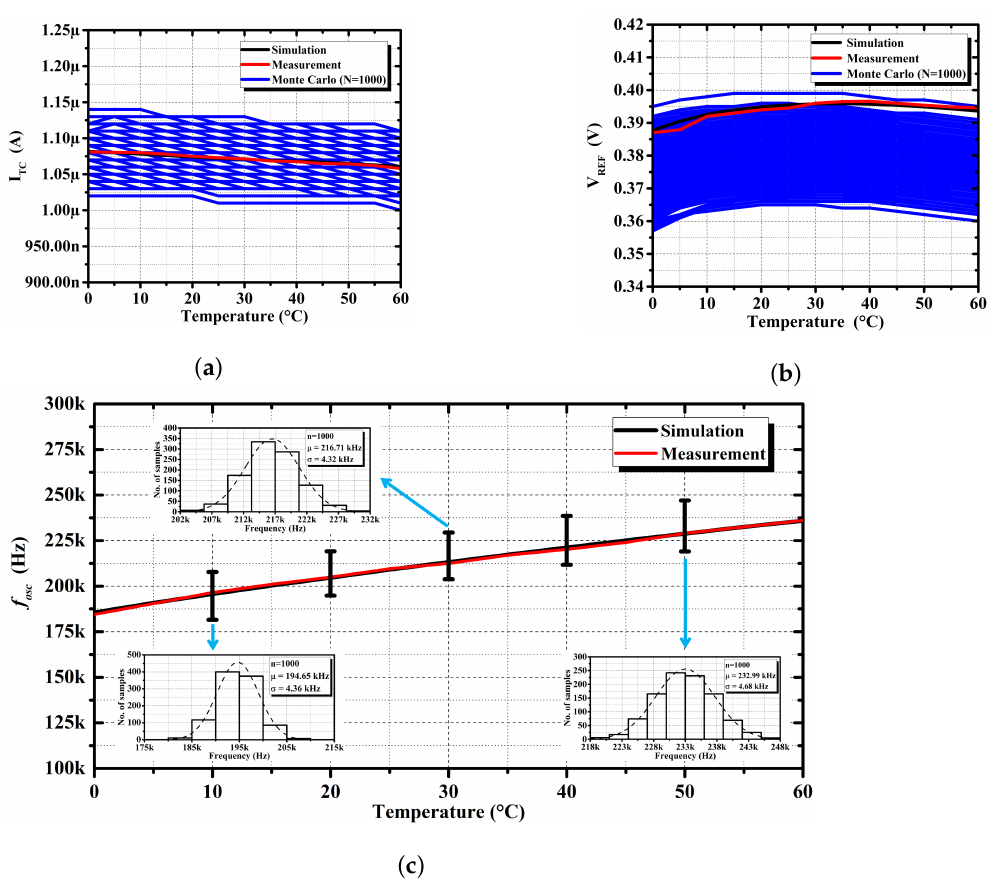
Figure 28. Temperature measurements of the LF section. ( a ) I TC vs. temperature. ( b ) V REF vs. temperature. ( c ) Frequency of oscillation vs. temperature.